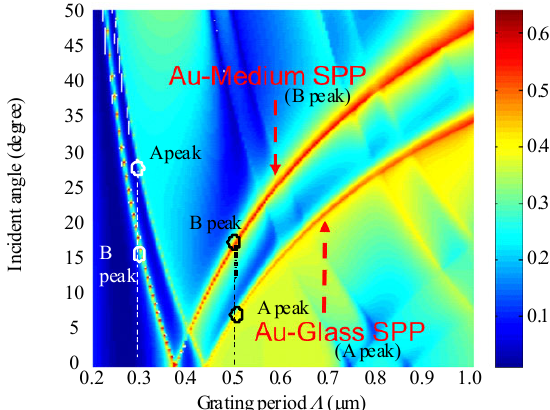
Fig. 7 Transmittance mapping obtained using the RCWA method.